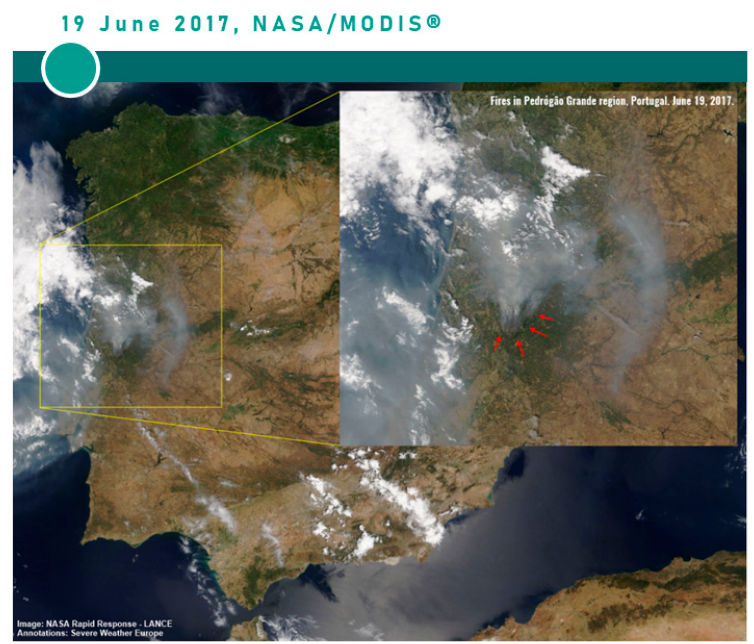
Figure 2. NASA/MODIS ® satellite image of the fires Pedrógão Grande in 19 June 2017.